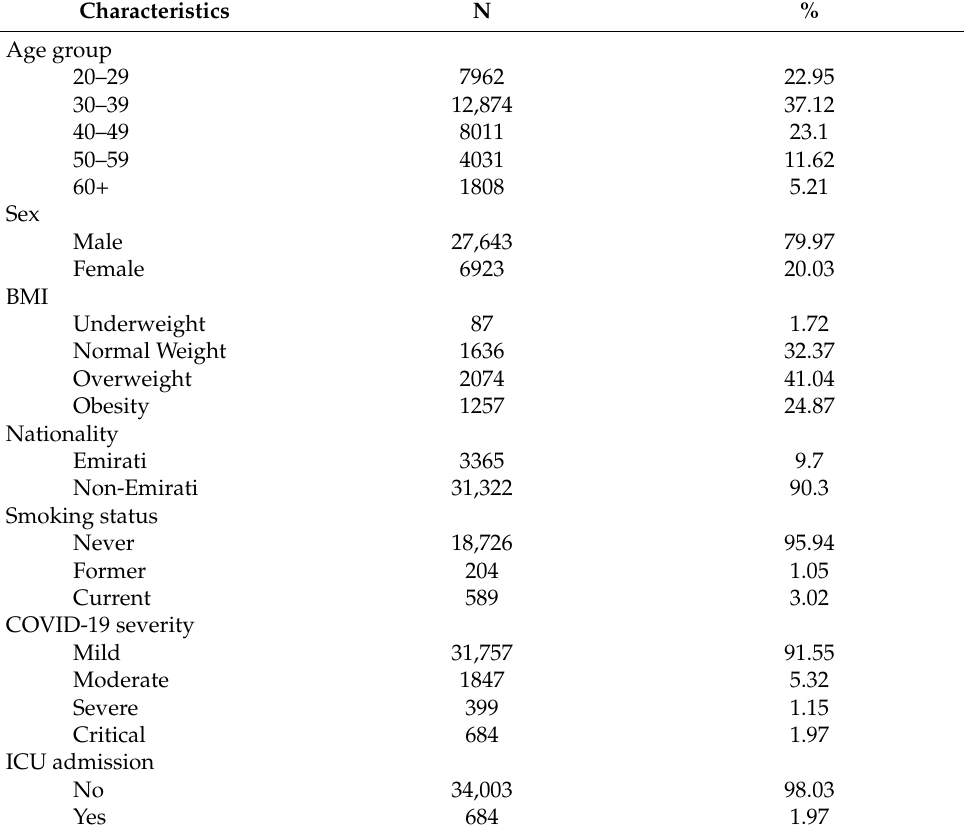
Table 1. Sociodemographic and health characteristics of the study